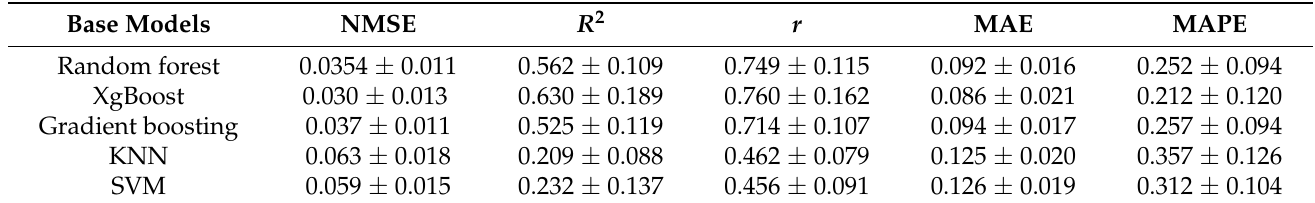
Table 4. The 10-fold cross-validation performance results of the proposed stacked machine learning model for predicting cardiovascular